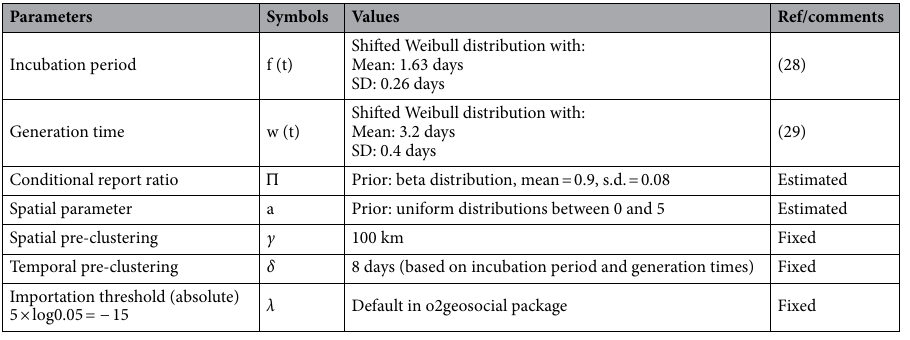
Table 1. Parameters used in the Bayesian